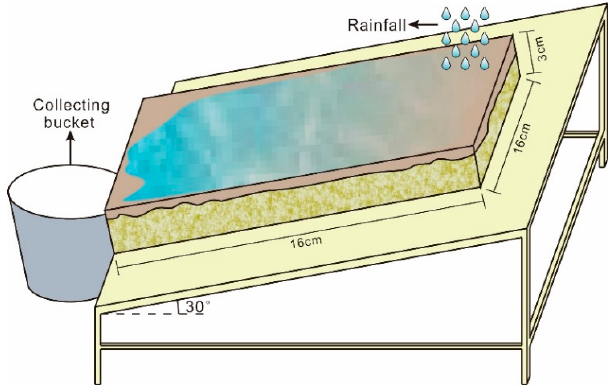
Figure 4. The rainfall erosion test simulator.